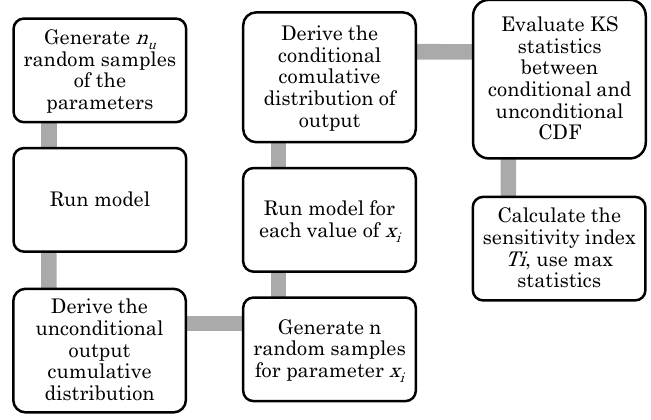
Fig. 2. Steps used to perform Kolmogorov Smirnov test ( Oi = Observed flow for ith day, Pi =Predicted flow by the model for ith day, 𝑂 ̅ = Mean of observed flow, and N = total number of time steps for one simulation